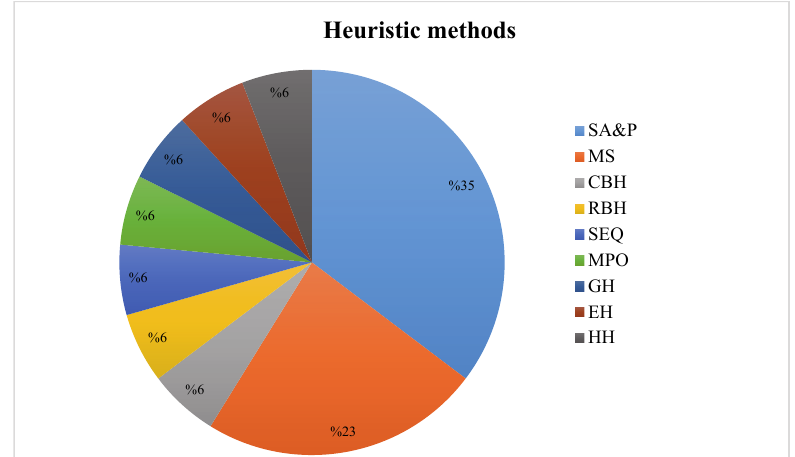
Fig. 8. Distribution of heuristic